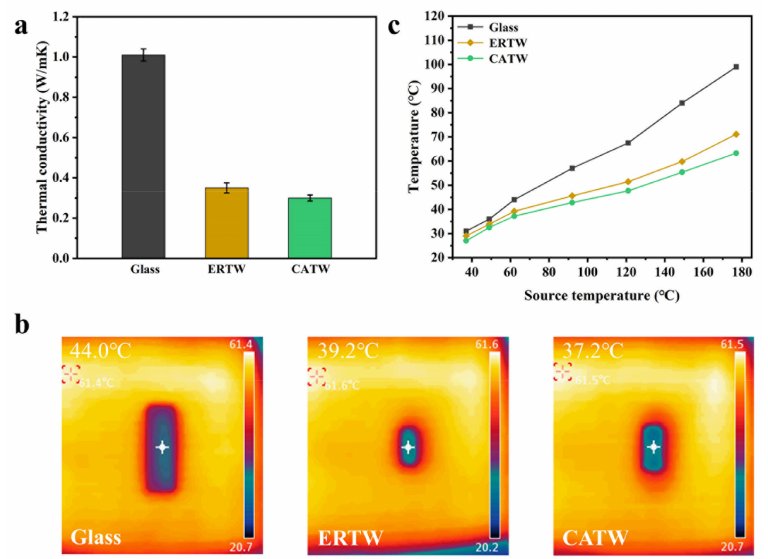
Figure 3. ( a ) Thermal conductivity of glass, epoxy resin transparent wood (ERTW), and CATW. ( b ) Thermal images of glass, ERTW, and CATW. ( c ) Stable backside temperatures at different temper- atures through direct contact of glass, ERTW, and CATW with conductive heat